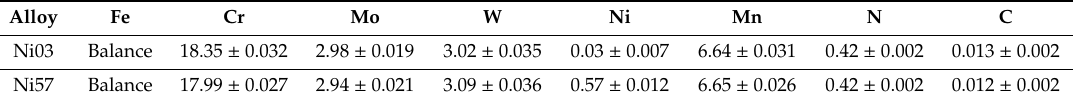
Table 1. Chemical compositions (in wt%) of the investigated alloys measured using optical emission spectroscopy and inductively coupled plasma atomic emission spectroscopy.